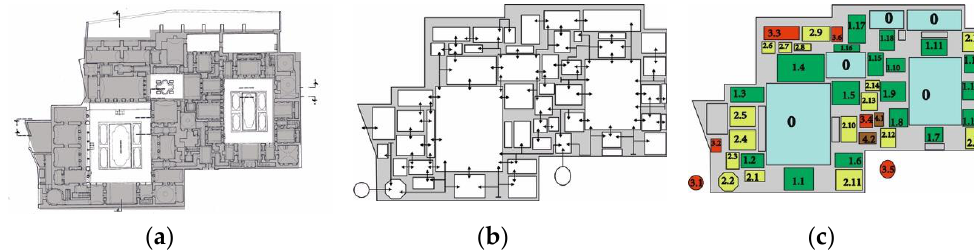
Figure 5. Golshan House: ( a ) floor plans, ( b ) space access and connection plan and ( c ) space grading. Table 3. Golshan House results.